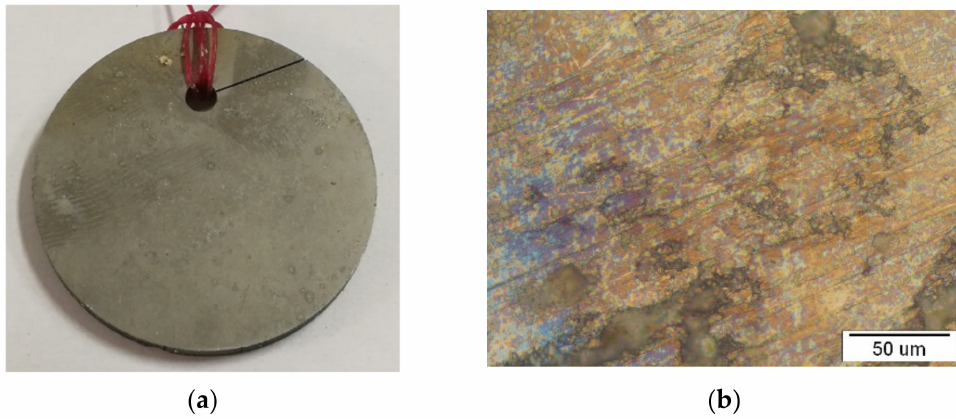
Figure 5. NiTi disc after 6 months in seawater: ( a ) presentation of a macro view and ( b ) representative optical